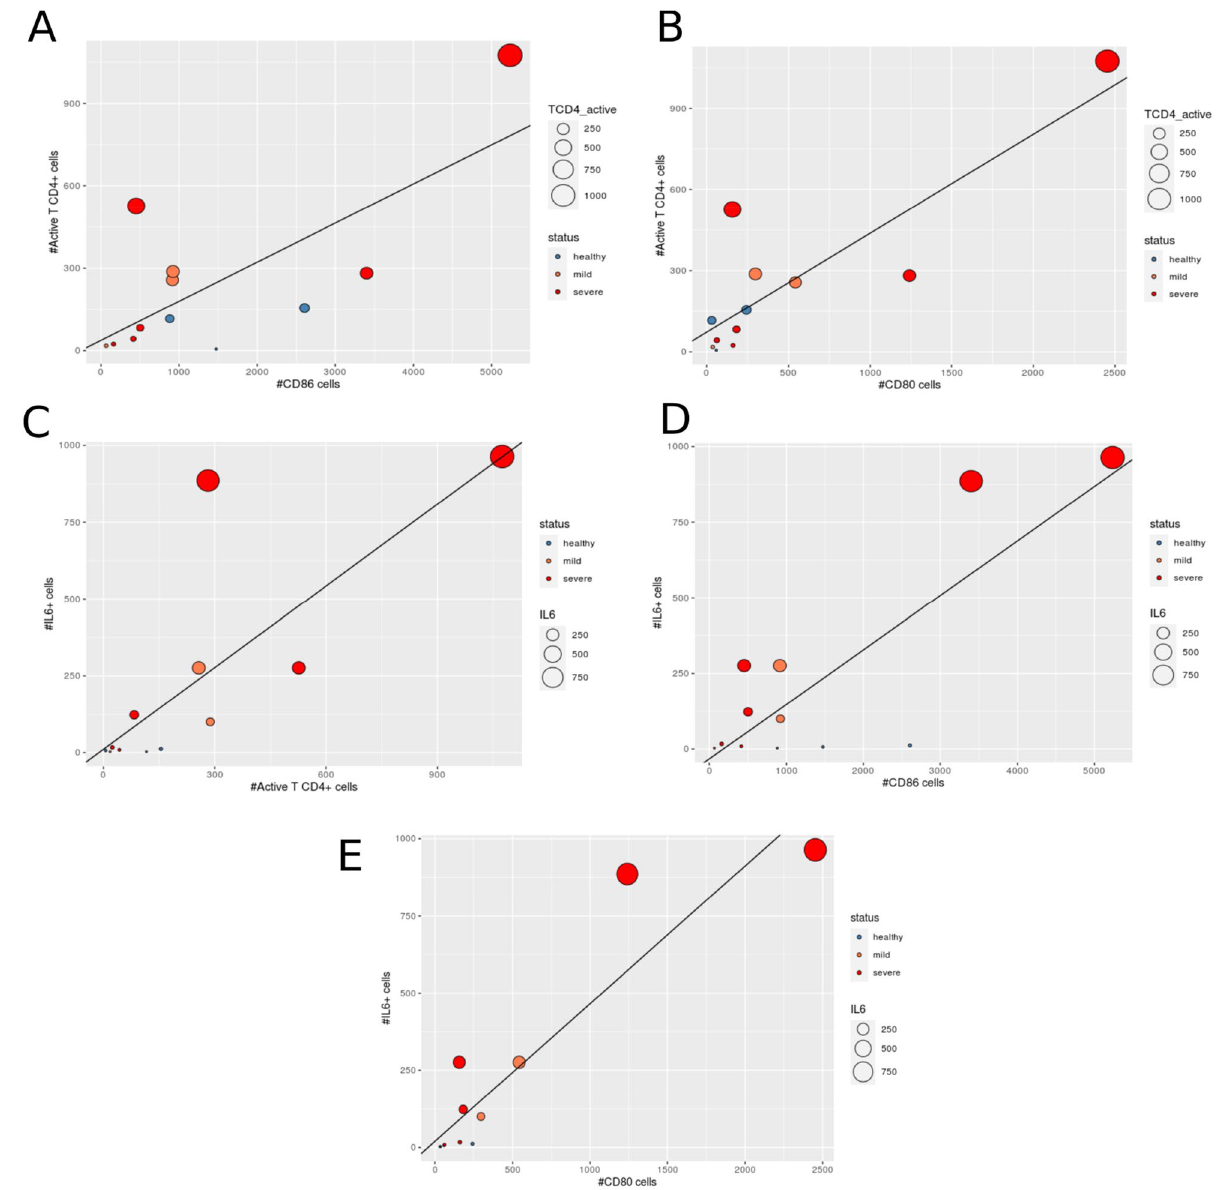
Figure 7. Elements of the CD80/86 axis in bronchoalveolar lavage fluid cells obtained from COVID-19 patients and controls. Plots showing the relationship between the elements of the proinflammatory signaling axis targeted by abatacept: CD80 + or CD86 + APCs, active CD4+ T cells and IL-6 producing macrophages. ( A ) CD86 + cells vs active CD4+ T cells (P = 0.013). ( B ) CD80 + cells vs active CD4+ T cells (P = 0.034). ( C ) active CD4+ T cells vs IL6 + cells (P = 0.067). ( D ) CD86 + cells vs IL6 + cells (P = 0.00036). ( E ) CD80 + cells vs IL6 + cells (P = 0.15). Gene expression units represent the corrected counts after applying normalization and variance stabilization approach implemented in scTransform